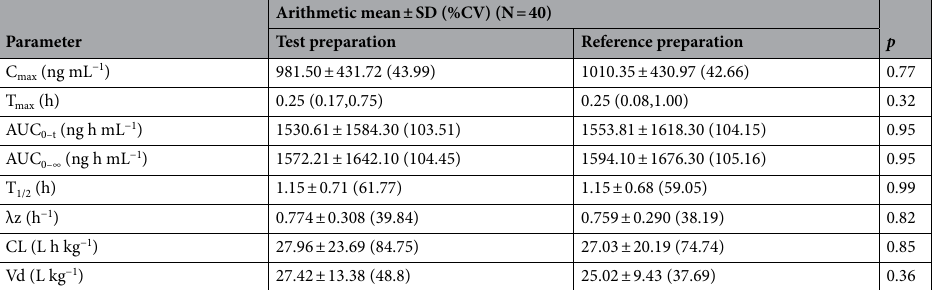
Table 1. Summary of main pharmacokinetic parameters of two formulations of Omeprazole and sodium bicarbonate powder. C max maximum blood concentration, T max time to maximum blood concentration, AUC 0–t Area under curve from time 0 (baseline) to time t, AUC 0–∞ Area under curve from zero to infinity, T 1/2 elimination half-life, λz apparent end elimination rate constant, CL plasma clearance, V d , apparent volume of distribution. Data was presented in mean ± standard deviation. p > 0.05, No significant.